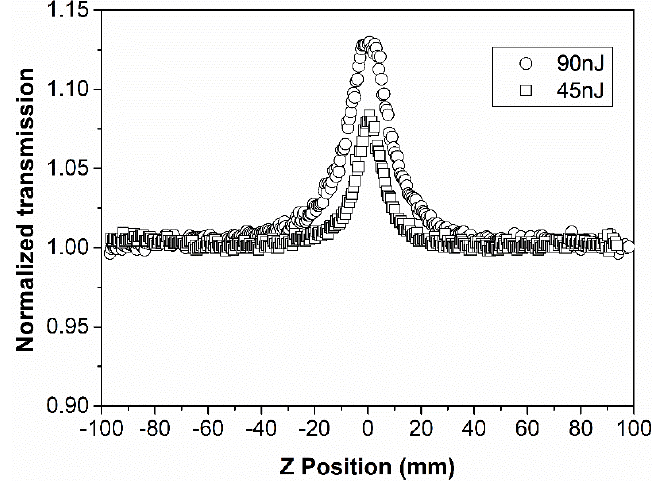
Figure 2. Single peak at relatively low energies (45 nJ and 90 nJ).